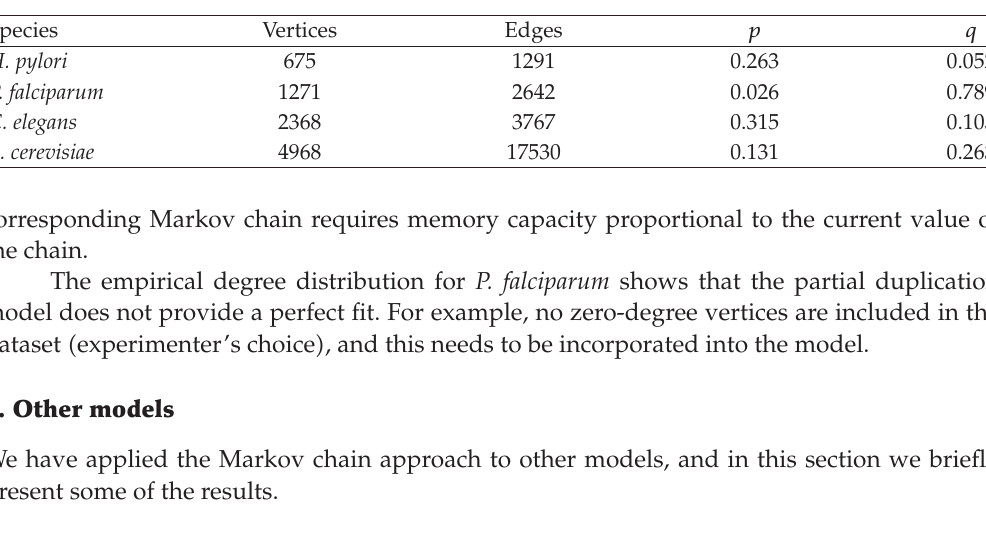
Table 1: Parameters estimated from protein interaction